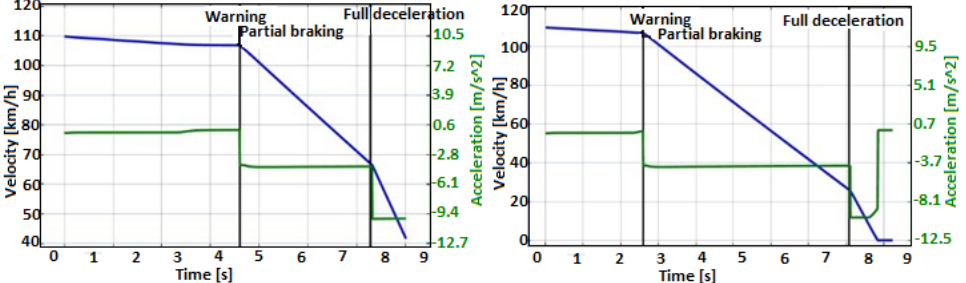
Figure 11. Speed profile of ego-vehicle. TTC = 2.6, TTC = 3.6. In the second scenario, we considered ego-vehicle speed, rolling coefficient, Time-to- Collision, trajectory and speed of the other road users to reconstruct the analysed crash. We modified the roll coefficient, trajectory and the TTC (indicated by green background) during the evaluation to investigate the impact of this factor on the outcomes of the crash (Figure 12).